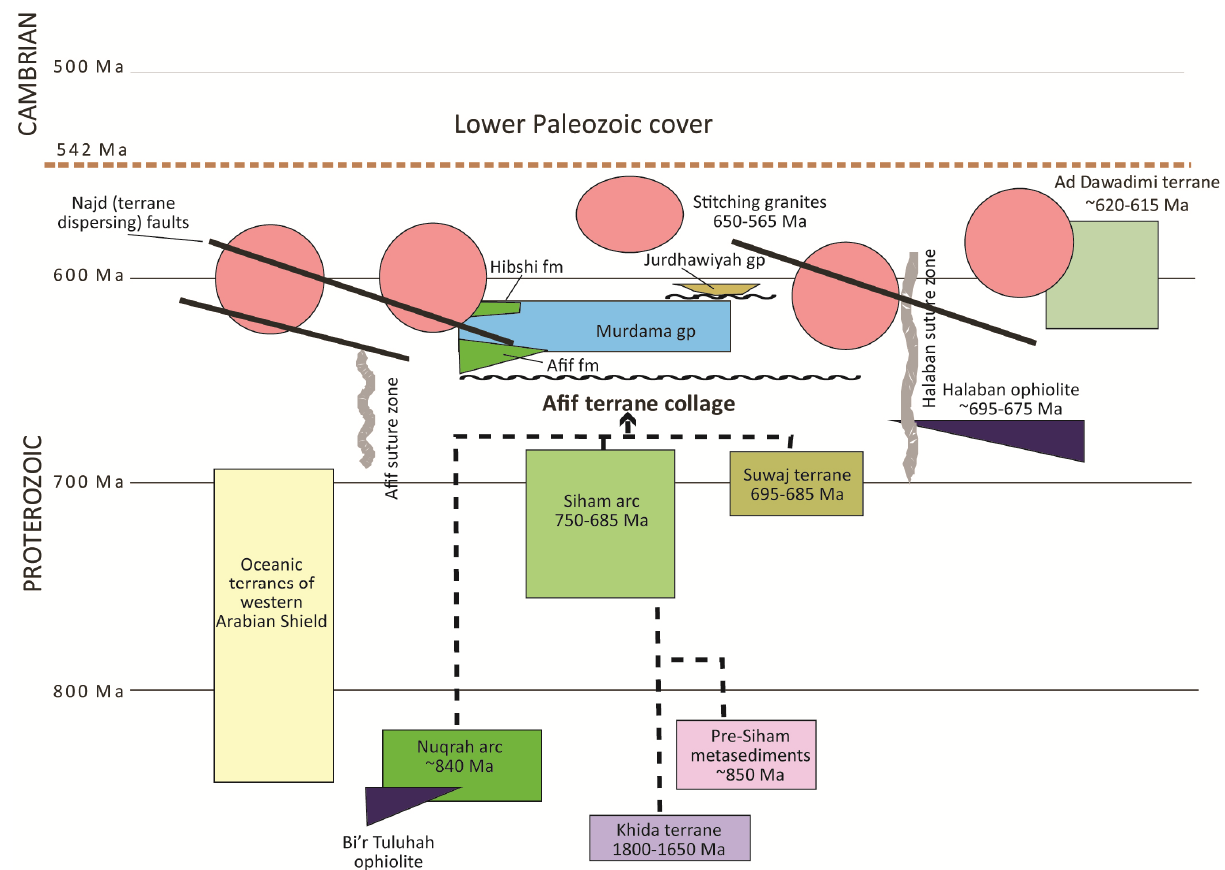
Figure 12. Schematic diagram showing the post-amalgamation setting of the Murdama basin composed of the Murdama group and volcanic units (Afif formation, Hibshi formation) unconformably overlying the Afif composite terrane. Following Murdama deposition, the Murdama basin was unconformably overlain by the Jurdhawiyah group and the entire region was intruded by 650–565 Ma stitching granites and disrupted by Najd